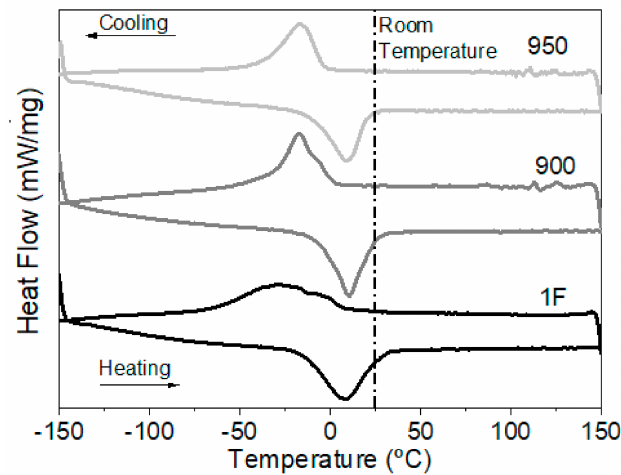
Figure 3. DSC plots of 1F, 900, and 950 samples.